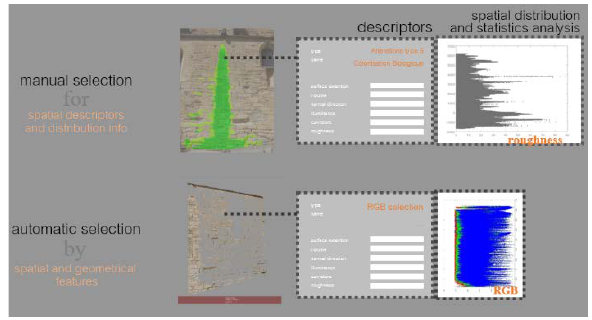
Figure 25. Implementation software for 3D semantic